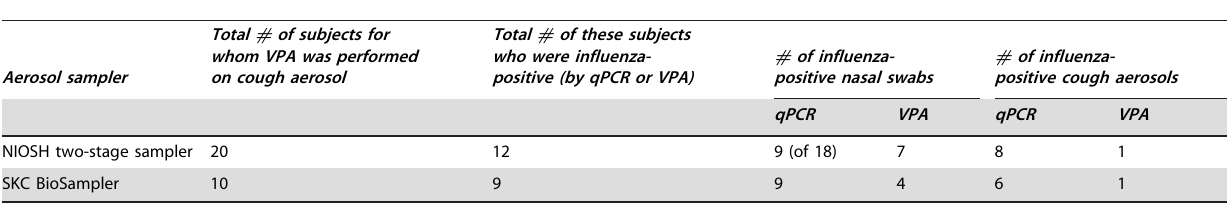
Table 2. Viral plaque assay results for cough-generated aerosols.